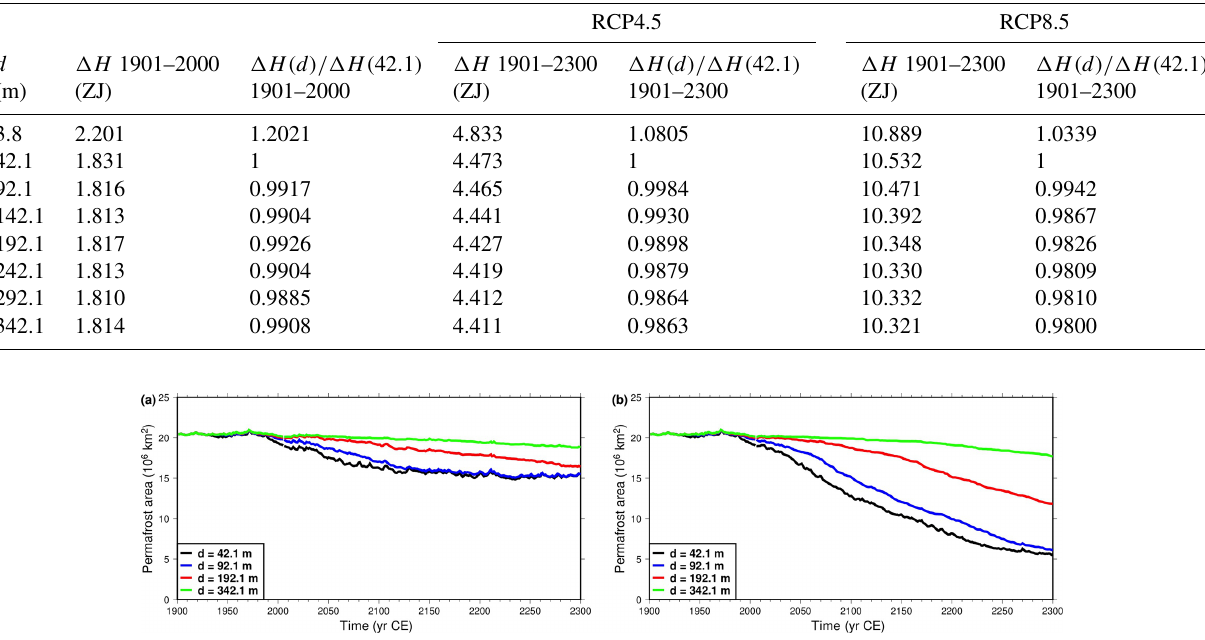
Figure 9. Northern Hemisphere intermediate-depth (0–42.1m) permafrost area as function of time. Model versions with bottom bound- ary depth d at 42.1m (black), 92.1m (blue), 192.1m (red) and 342.1m (green). (a) Simulations forced with CRUNCEP+RCP4.5 data. (b) Simulations forced with CRUNCEP+RCP8.5